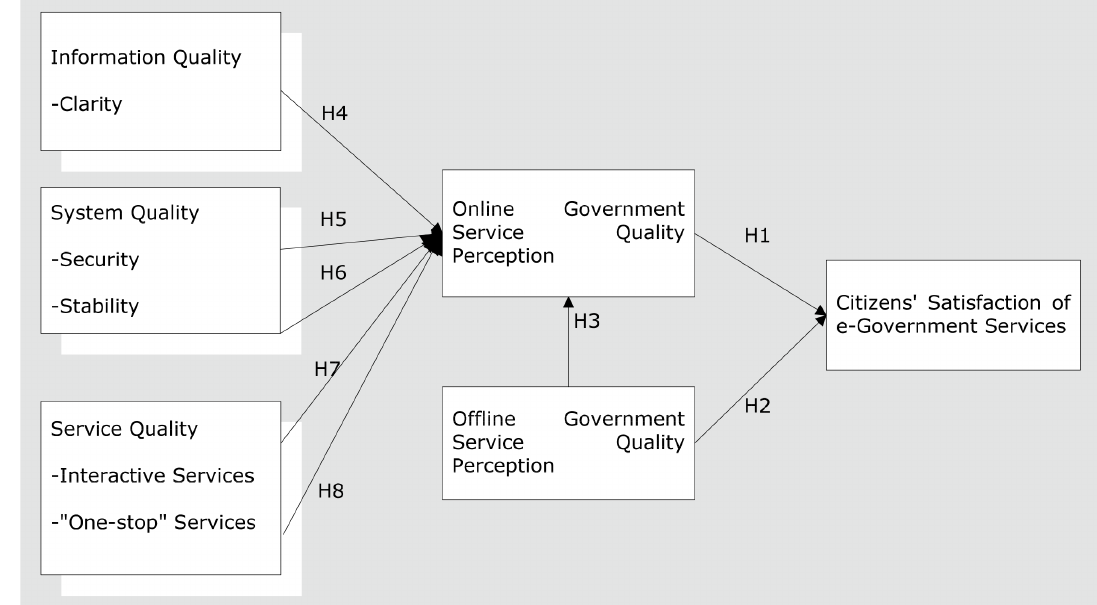
Figure 3. Conceptual model of e-government services